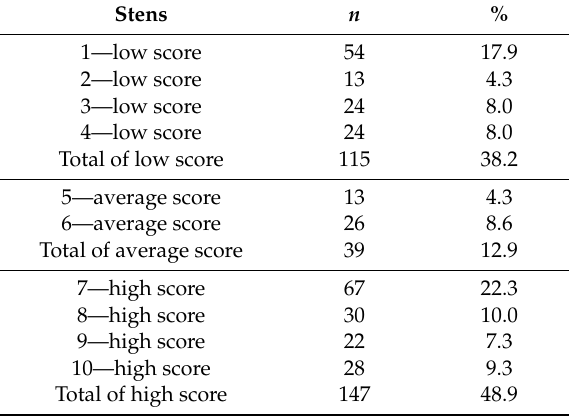
Table 2. Distribution of sten scores examined in the generalized self-e ffi cacy scale